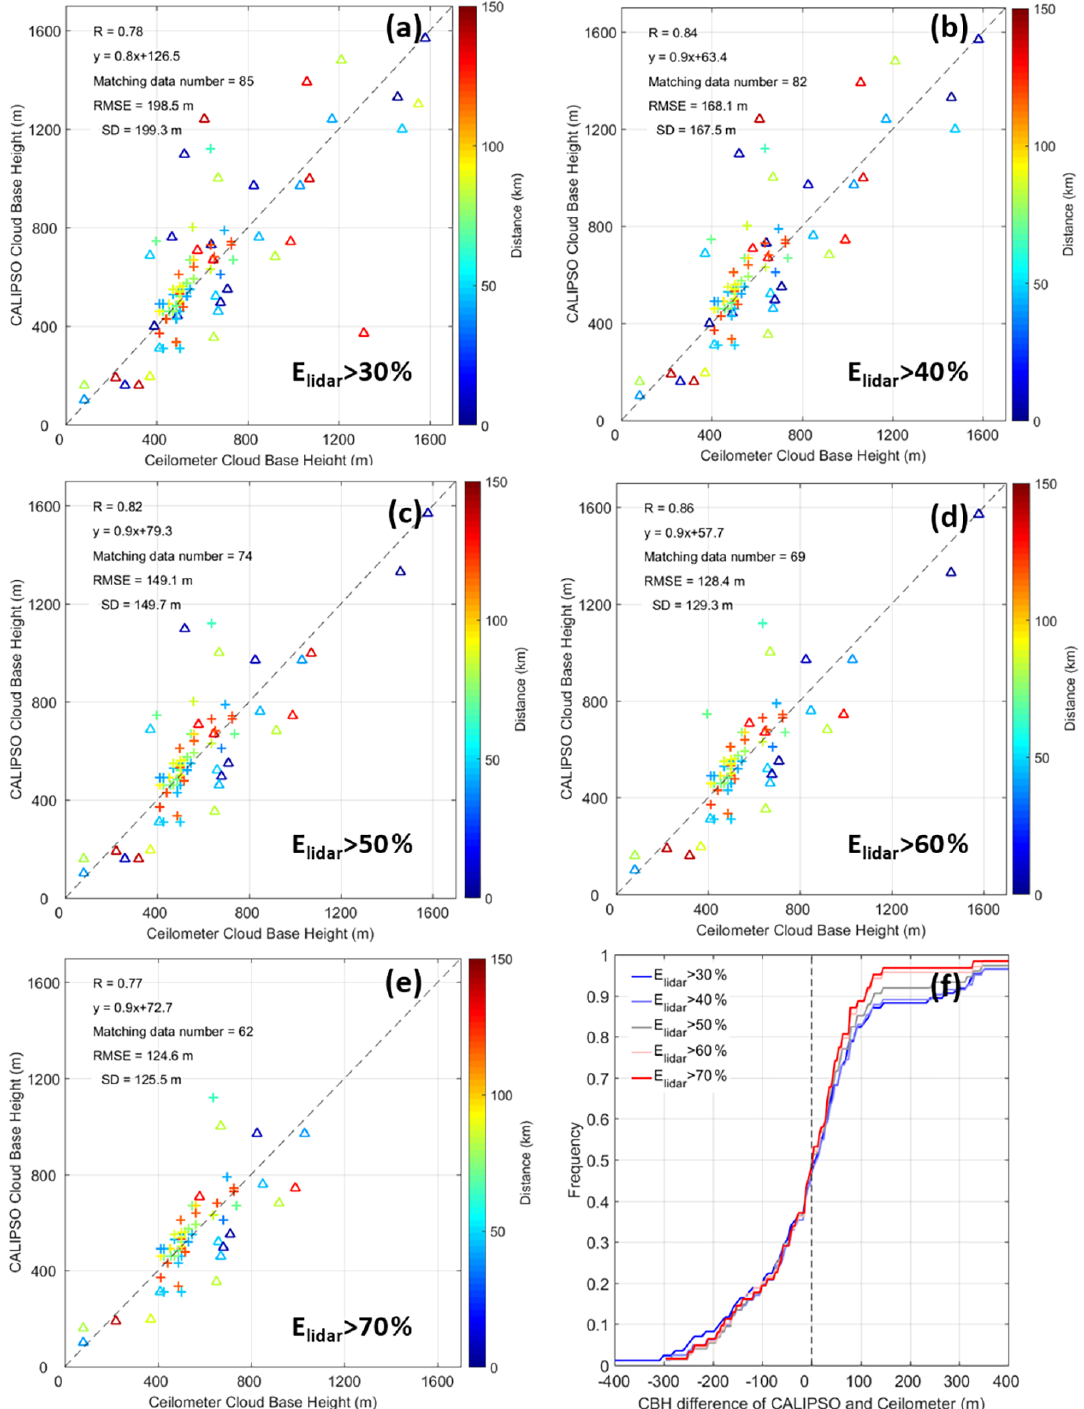
Figure 6. (a) Same as Fig. 5 but for selecting scenes with penetration efficiency of 333m horizontal resolution cloud features ( E lidar ) > 30%. The selection criteria of multilayer cloud fraction are the same as Fig. 5c. The triangle represents the data for the ENA site, and the crosses represent the data for the Barbados site. The color represents the shortest distance from the CALIPSO ground track to the ceilometer site. Panels (b) , (c) , (d) , and (e) are the same as panel (a) , but the selection criteria of E lidar in panel (b) are larger than 40%, in panel (c) they are larger than 50%, in panel (d) they are larger than 60%, and in panel (e) they are larger than 70%, respectively. (f) Cumulative distribution of the difference between CALIPSO CBH and ceilometer CBH at two sites in 2017. Different colored lines represent the cumulative distribution at different selection criteria of E lidar